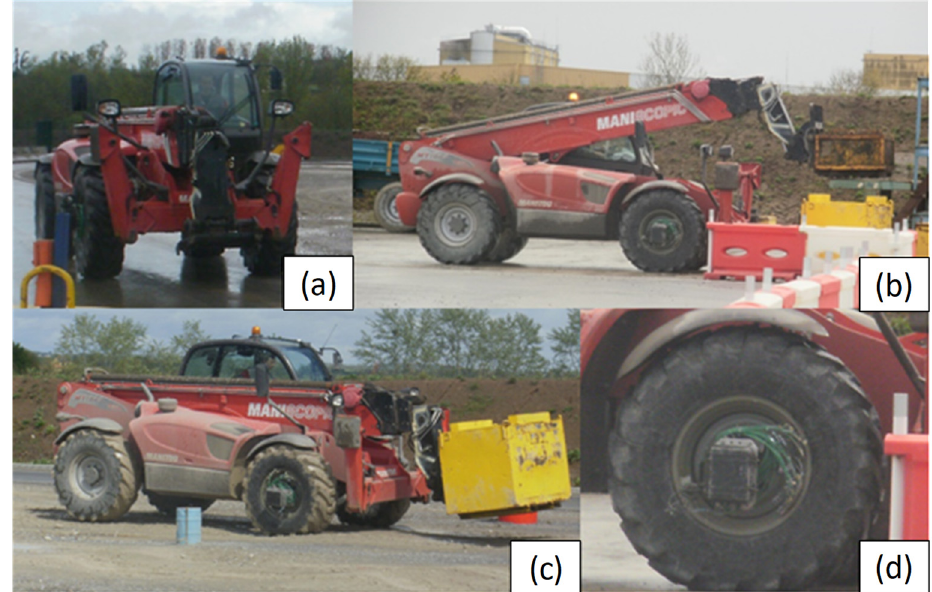
Figure 2. Different load conditions applied to the machine: ( a ) on-road case; ( b ) load placement case; ( c ) off-road case; ( d ) strain gauges and data system applied to the wheel to acquire and register the strain time-histories.